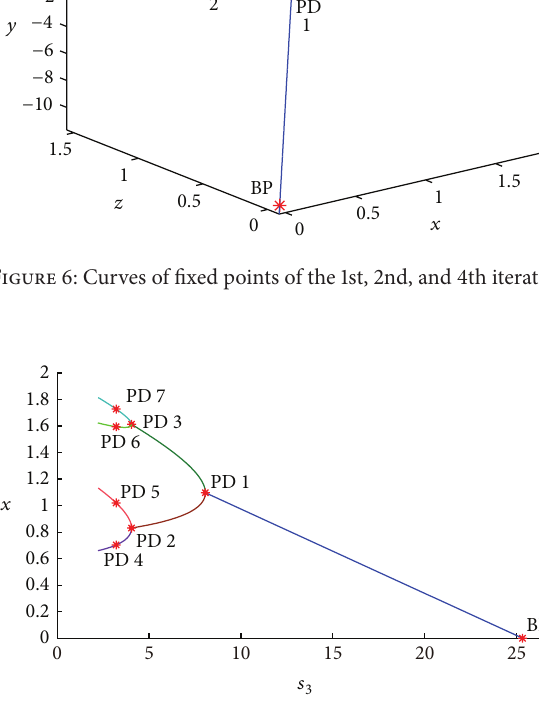
Figure 7: Continuation of 𝐸 1 in ( 𝑠 3 , 𝑥